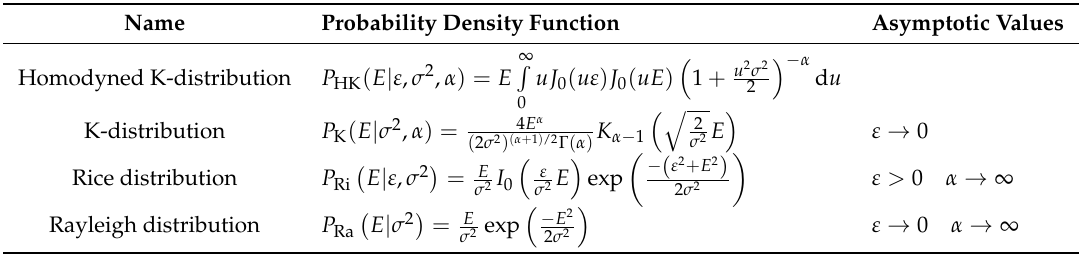
Table 1. Distribution functions used to describe soft tissues behaviour. Overview of models in [29].